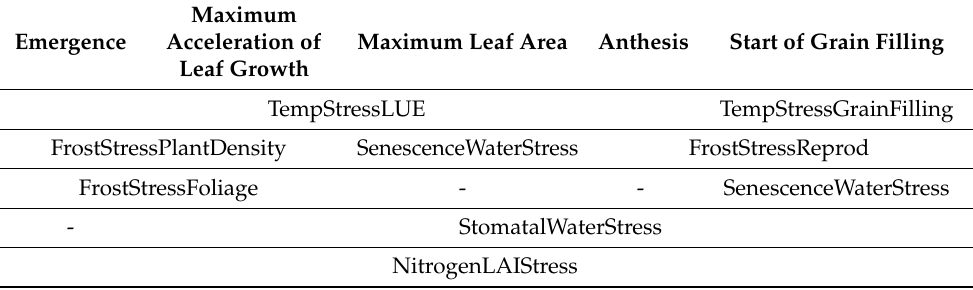
Table 2. Phenological phases during which crop stress variables are used to compute the stress